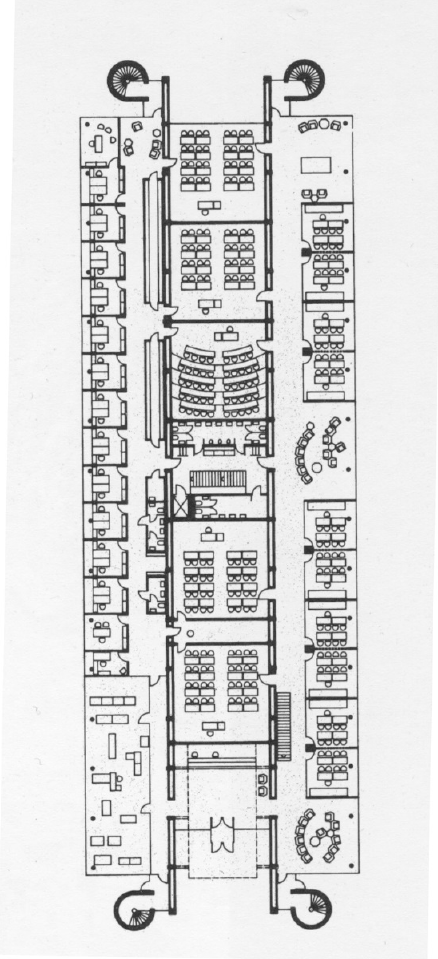
Figure 6. Plan of IBM with auditoriums served by installation walls and offices and seminar rooms in the aisles.